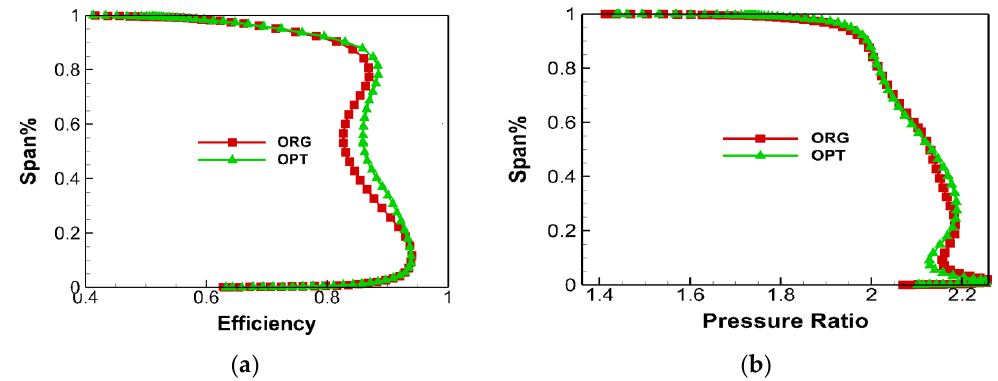
Figure 10. The span performance of the original and optimized tandem rotor. ( a ) The efficiency; ( b ) the total pressure ratio.